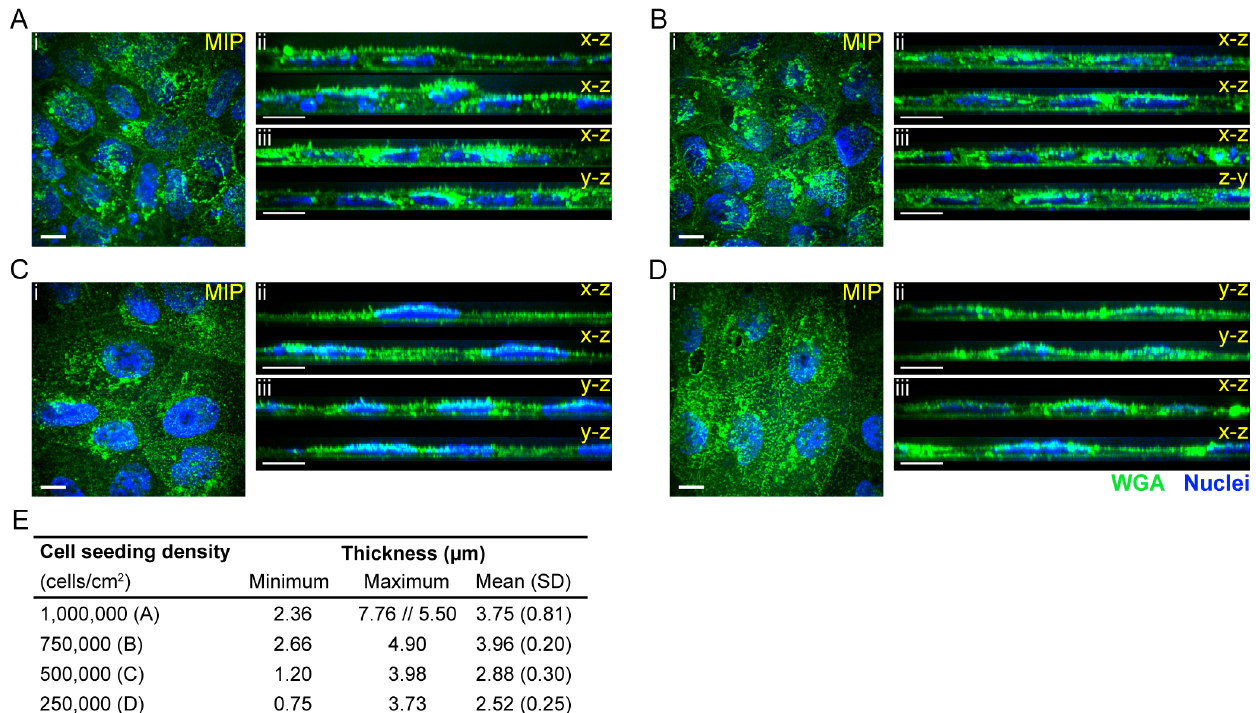
Figure 2. Lower iBMEC plating densities result in a monolayer with thinner, more elongated cells. The differentiated iBMECs were plated on ThinCert ® membranes at 1 million ( A ), 750,000 ( B ), 500,000 ( C ), and 250,000 ( D ) cells/cm 2 densities. Representative maximum intensity projection (MIP) confocal micrographs of several z -stack in the middle section of the monolayer ( Ai – Di ) and the x – z ( Aii – Cii ) or y – z ( Dii ) cross-sectional view of two regions. ( Aiii – Diii ) Two cross-sectional images of other regions that were imaged (MIP is not presented). Scale bars represent 10 µ m. ( E ) Minimum, maximum, and mean (SD) thickness of the iBMECs monolayer. The thickness was determined based on the cross-sectional view of several regions of several images.